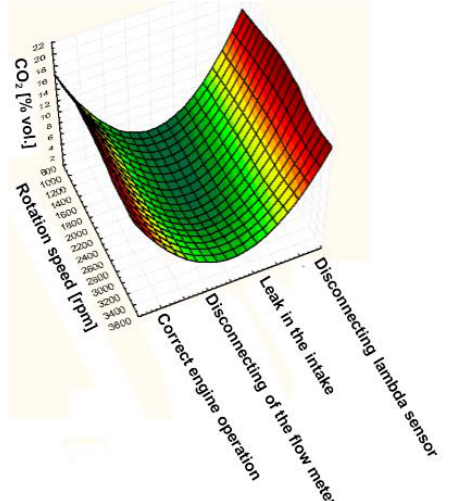
Fig. 15. The content of carbon dioxide as a function of rotational speed for an efficient engine and simulated damage – a petrol-fueled engine